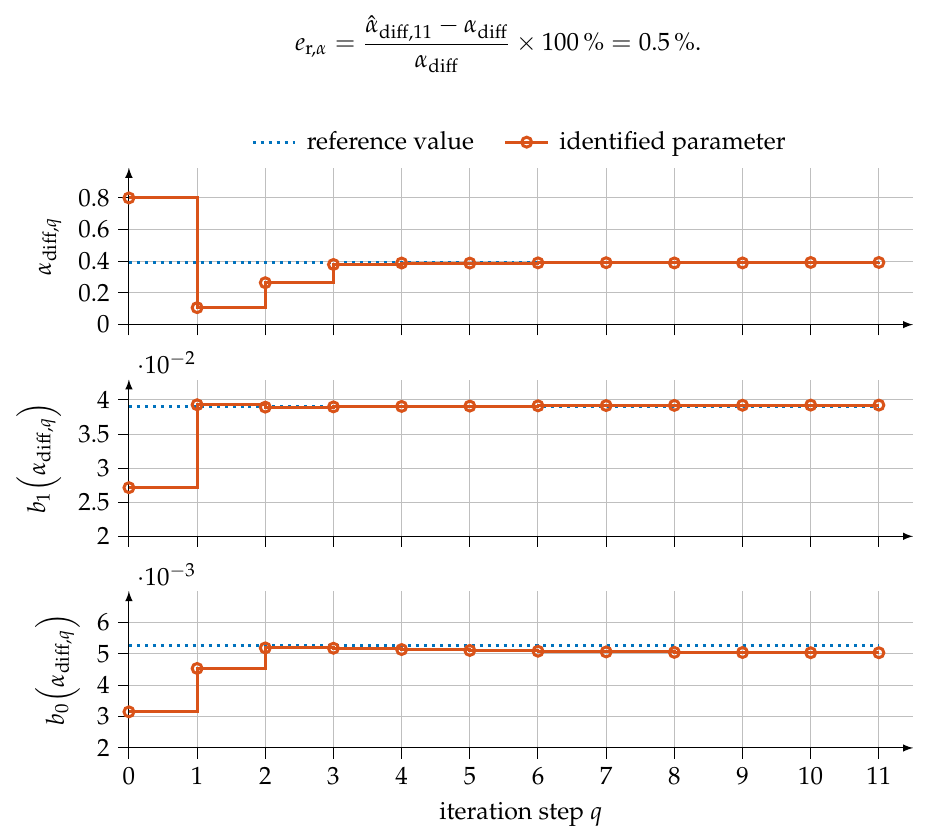
Figure 7. The identification results of the proposed method for a lithium-ion battery using real